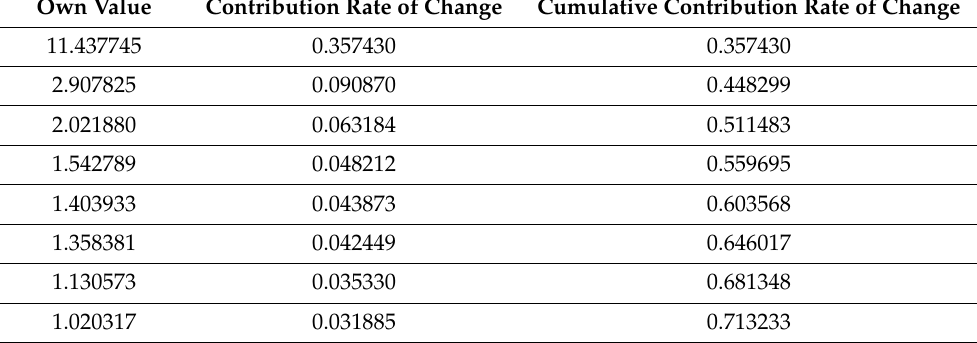
Table 4. Contribution rates.